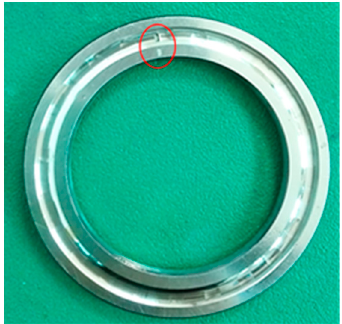
Figure 21. Spalling defect on the ring of the thrust ball bearing.